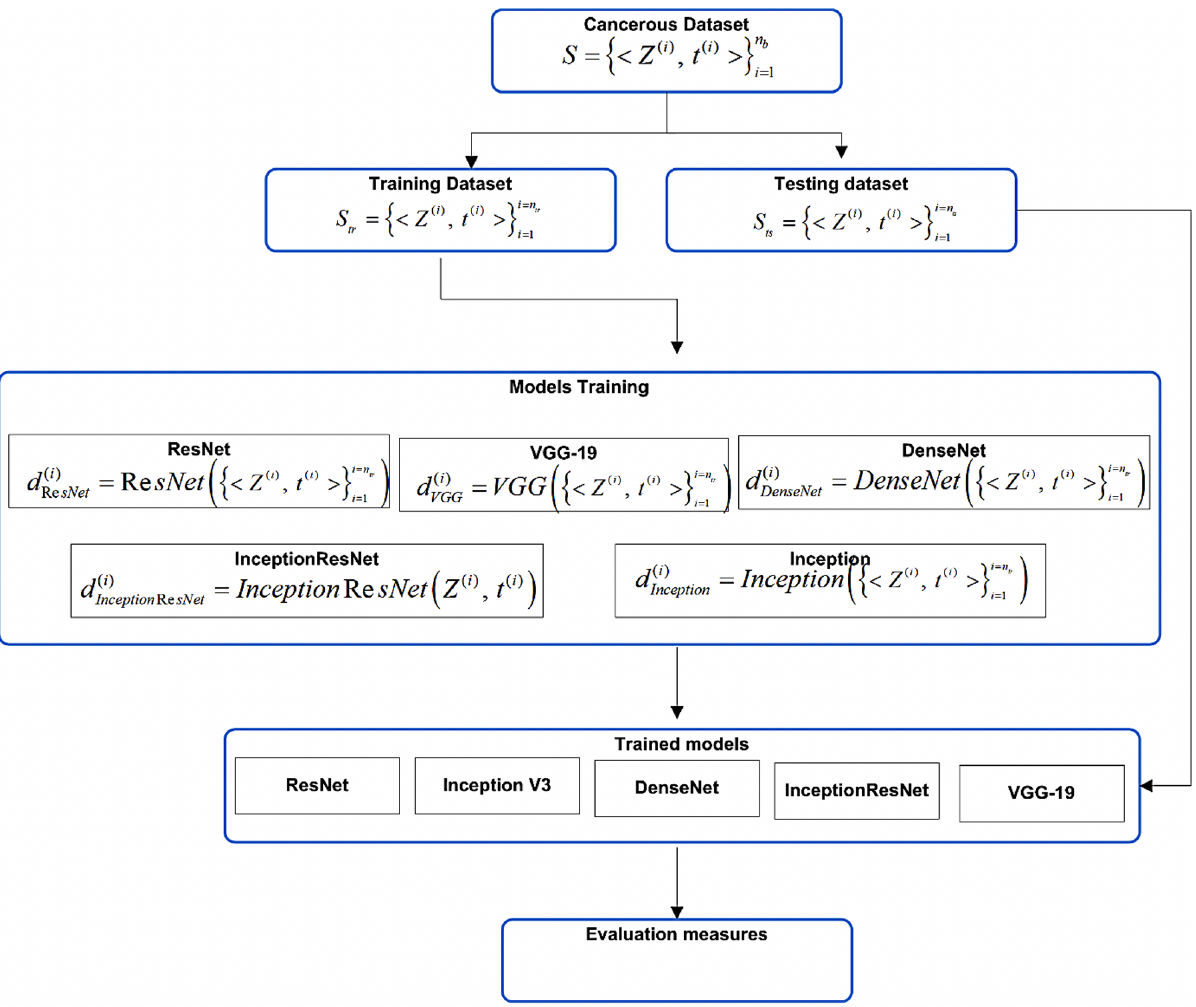
Figure 1. Block diagram of individual